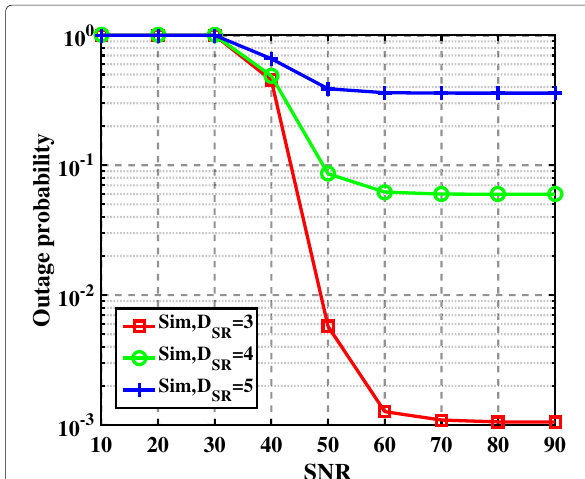
Fig. 11 Outage probability vs. SNR for trusted SUs with different D